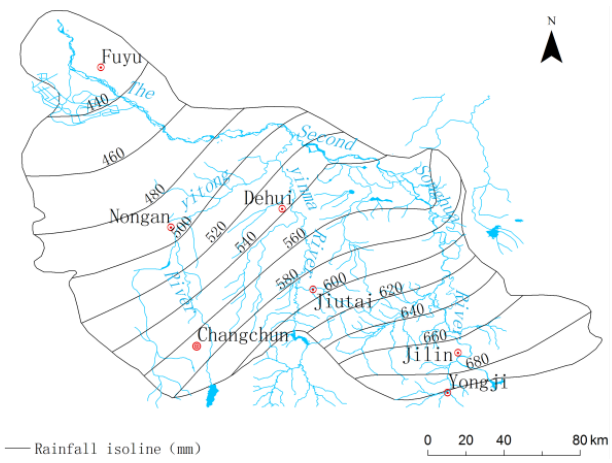
Figure 2. Rainfall isoline in the study area.